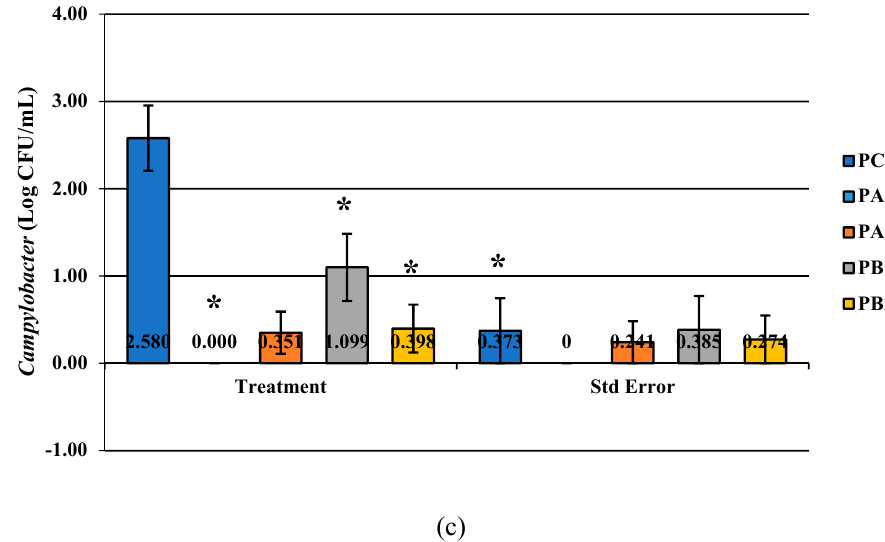
Figure 2. The e ff ect of PeraClean, a PAA acid sanitizer, used as an antimicrobial dip (400 or 600 ppm) and in a stationary chilling tank (25 or 45 ppm) on the load of Salmonella ( a ), total coliforms ( b ), and Campylobacter ( c ) present in the rinsates of 42-d-old Ross 708 broilers. The means are numerically stated on the bar graph. N = 50, n = 10, p < 0.0001 (a); N = 50, n = 10, p < 0.0001 (b); N = 50, n = 10, p < 0.0001 (c). PA1 refers to a 400 ppm / 25 ppm treatment, PA2 refers to a 400 ppm / 45 ppm treatment, PB1 refers to a 600 ppm / 25 ppm treatment, and PB2 refers to a 600 ppm / 45 ppm treatment, with each treatment being first a post-evisceration dip followed by an immersion chill.